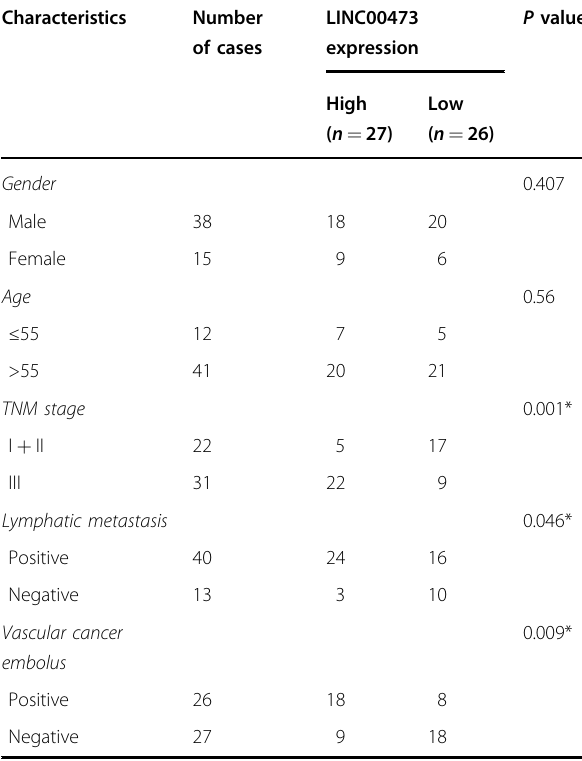
Table 1 The correlation between LINC00473 expression and the clinicopathological factors of 53 GC